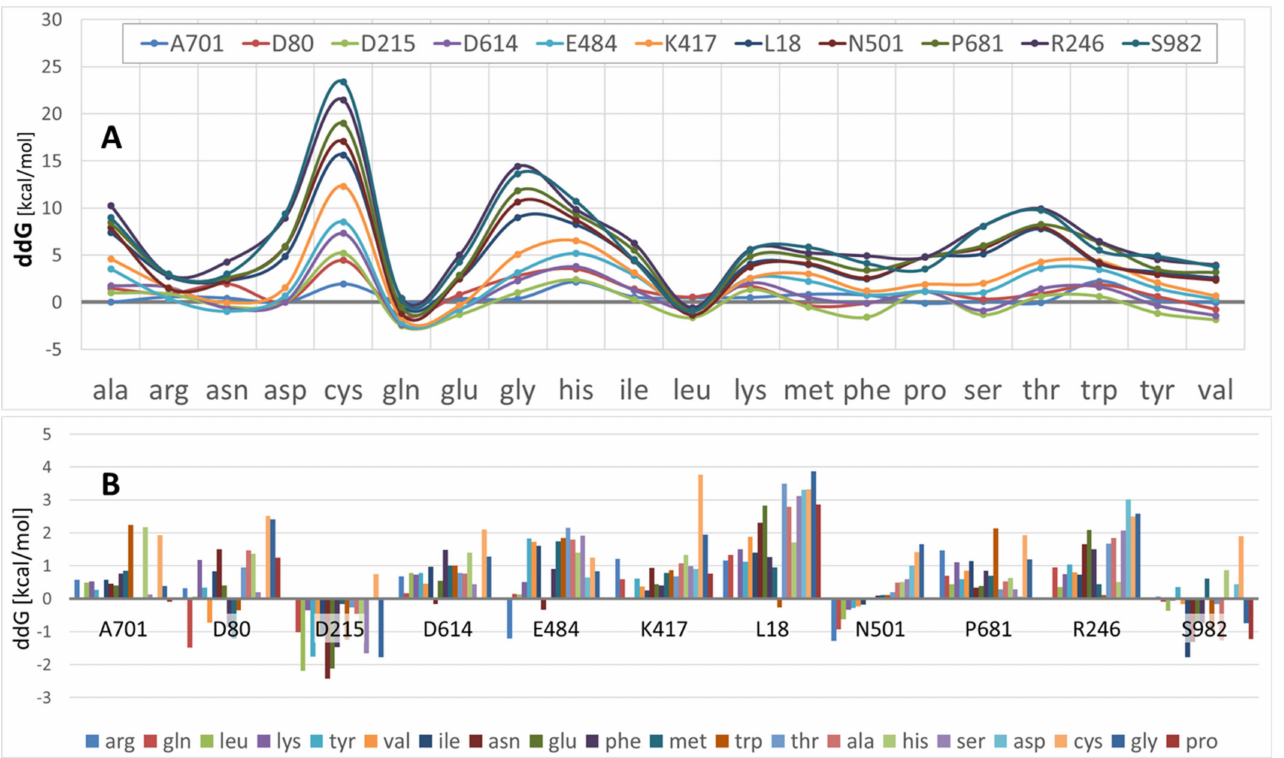
Figure 3. ( A ) Stacked line graphic comparing S-protein ddG across 11 single-point mutations (color- coded lines) for all 20 amino acid substitutions. Computed ddG values falling below “0” enhance proteo-stability of the S-protein. ( B ) Calculated ddG values as a function of mutation site (e.g., N501) and amino acid substitutions (color-coded). More positive ddG values reflect increasing protein instability. On average S-protein sites D80, D215, N501, and S982 resulted in enhanced proteo-stability, i.e., stability was enhanced at each of these sites for a larger proportion of the amino acid population. Abbreviations: Ala, alanine; Arg, arginine; Asn, asparagine; Asp, aspartic acid; Cys, cysteine; Gln, glutamine; Glu, glutamic acid; Gly, glycine; His, histidine; Ile, isoleucine; Leu, leucine; Lys, lysine; Met, methionine; Phe, phenylalanine; Pro, proline; Ser, serine; T, threonine; Trp, tryptophan; Tyr, tyrosine; Val,